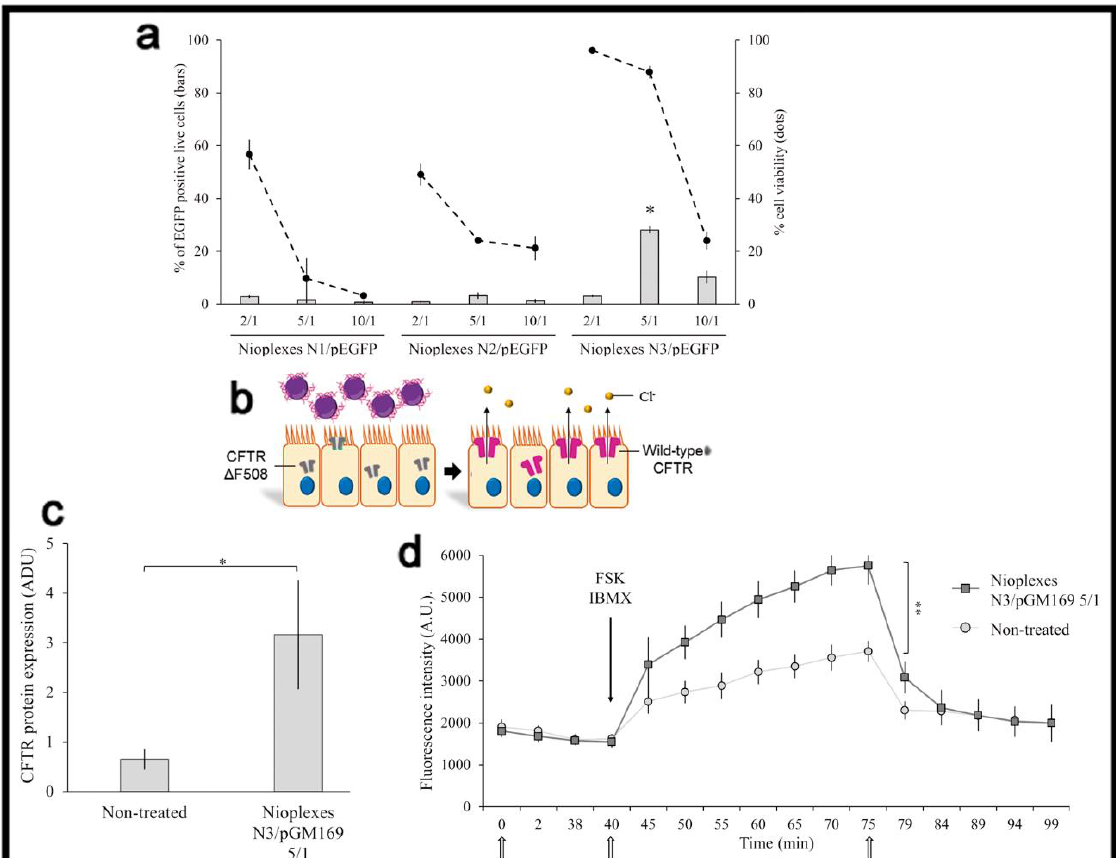
Figure 5. Transfection efficiency and therapeutic effect. ( a ) Percentage of live transfected CuFi-1 cells with the pEGFP reporter plasmid. ( b ) General scheme of transfection process with pGM169 therapeutic plasmid. ( c ) CFTR/β-actin protein expression determined by Western blot. ( d ) CFTR chloride channel activity determined by SPQ analysis. Reproduced with permission of [38].